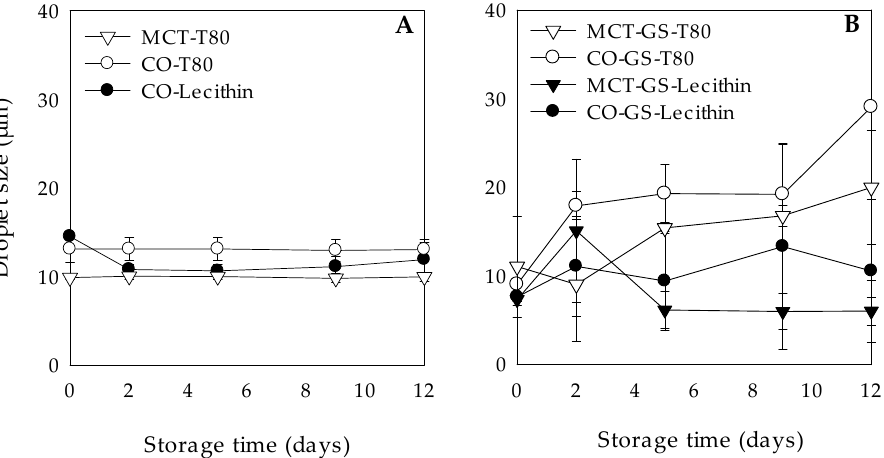
Figure 1. Droplet size (D [4;3] ) during 12 days of dark storage at 4 °C of chlorophyllin-loaded W 1 /O/W 2 emulsions formulated with different lipid phases consisting on medium chain triglyceride (MCT) or corn oil (CO) and without ( A ) or with ( B ) glyceryl stearate (GS) as well as different hydrophilic surfactants (Tween 80 (T80) or Lecithin).